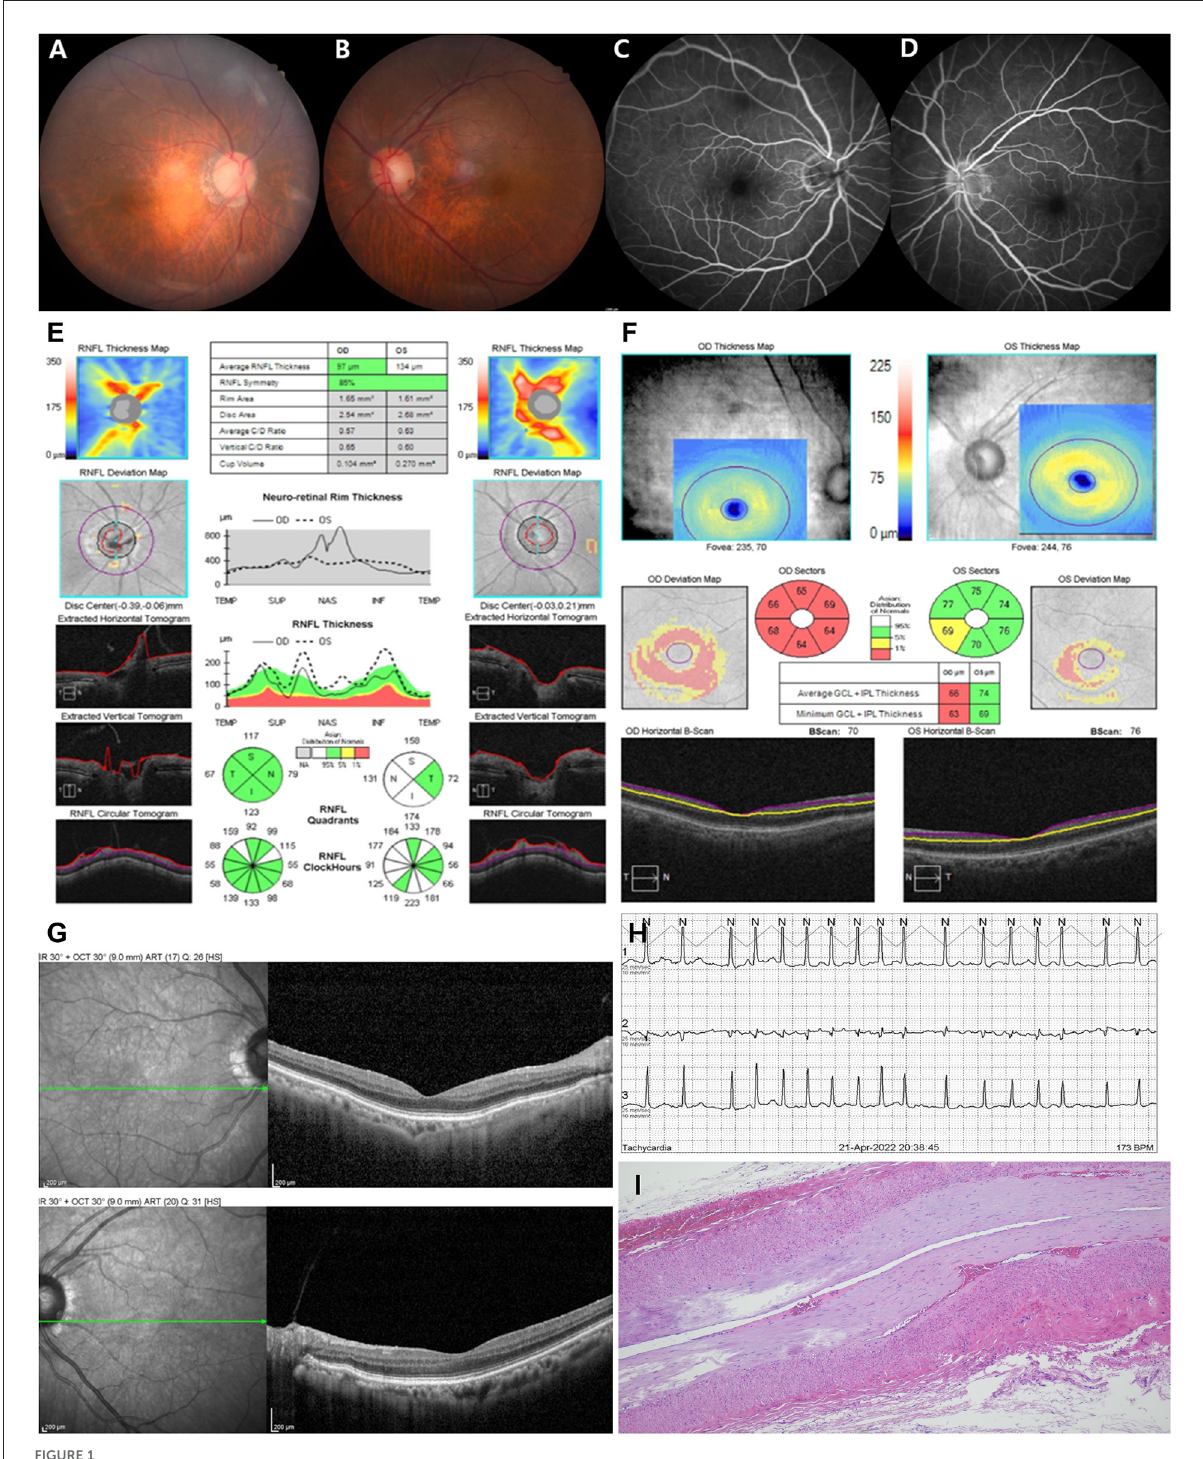
FIGURE1 Fundus photography did not show disc swelling in either eye (A,B) but mild atrophy in the right eye (A) , and fluorescence angiography did not show optic disc leakage or vascular filling defect in both eyes (C,D) . Optical coherence tomography (OCT) showed normal average retinal nerve fiber layer (RNFL) thickness in both eyes (E) but the thickness of the ganglion cell complex (GCC) layer in the right eye was decreased (F) . OCT did not show a significant change in inner retinal layer thickness (G) . Twenty-four-hour Holter monitor showed atrial fibrillation (AF) with rapid ventricular response at a rate of 173 beats per minute (H) . Photomicrograph of a temporal artery showed mild intimal thickening, otherwise nonspecific (I) . ONH, optic nerve